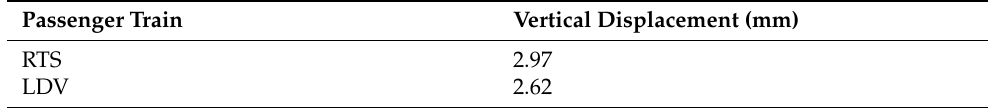
Figure 8. Results of a vertical displacement measurement with the LDV Polytec PDV 100 for a freight train in motion. Table 4. Numerically evaluated vertical displacement for Passenger Train.